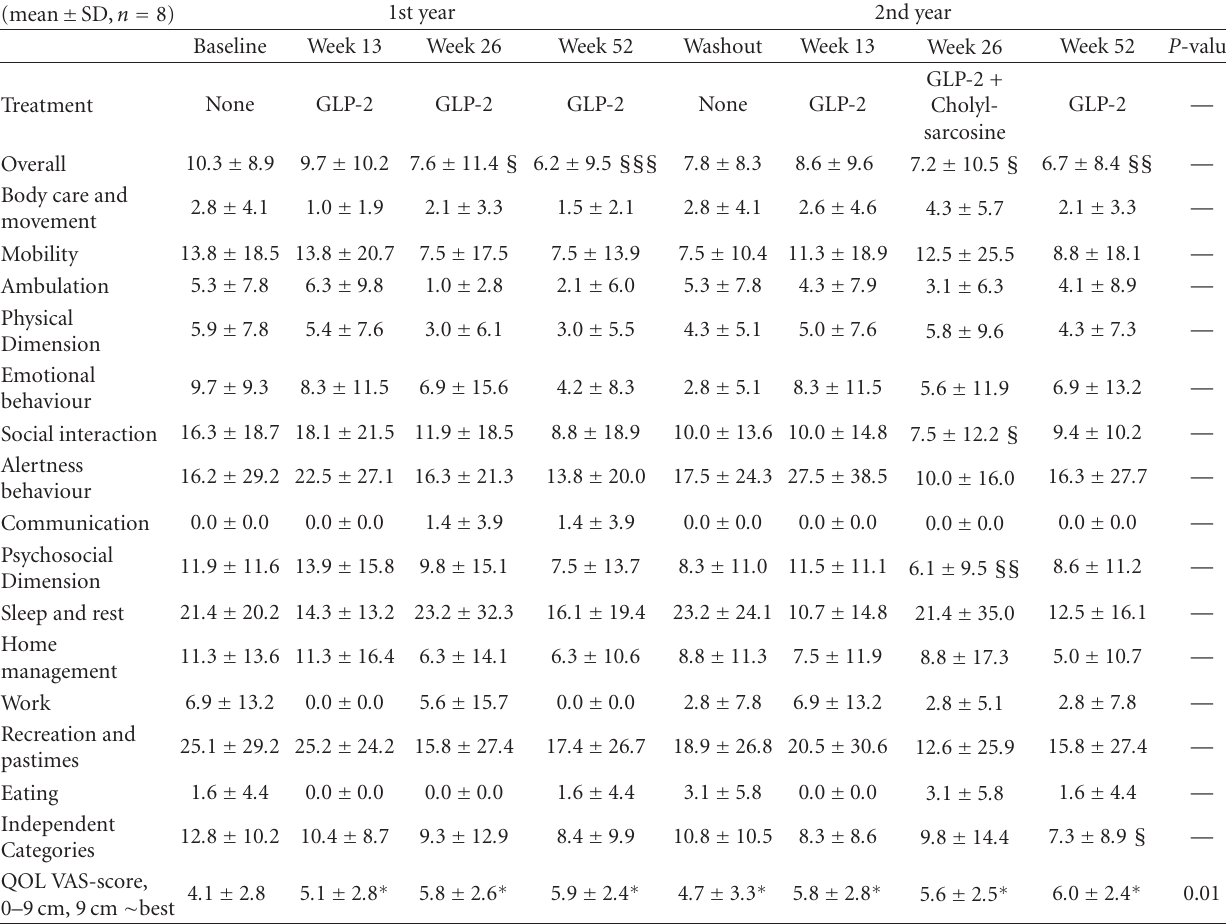
Table 2: Sickness impact profile, SIP (0% ∼